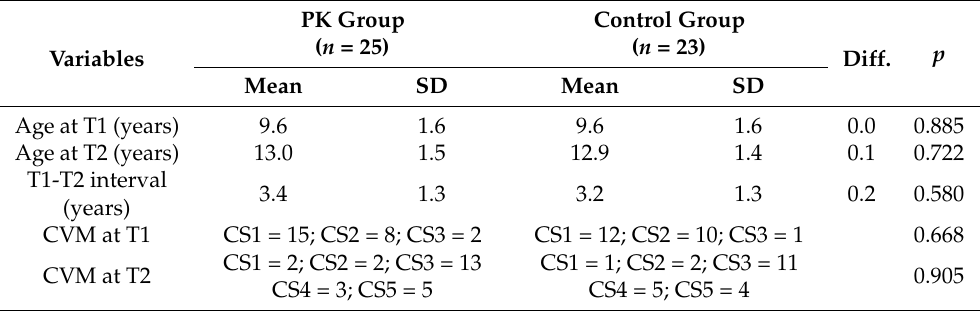
Table 1. Demographics with statistical comparisons (independent-samples t- tests, Mann–Whitney U tests, or Chi-square